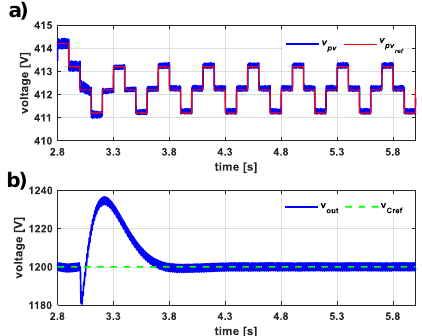
Figure 11. PV and the DC-link voltage behaviors: ( a ) PV voltage (blue line) and maximum power point (MPP) voltage reference (red line); ( b ) DC-link voltage (blue line) and corresponding reference voltage.